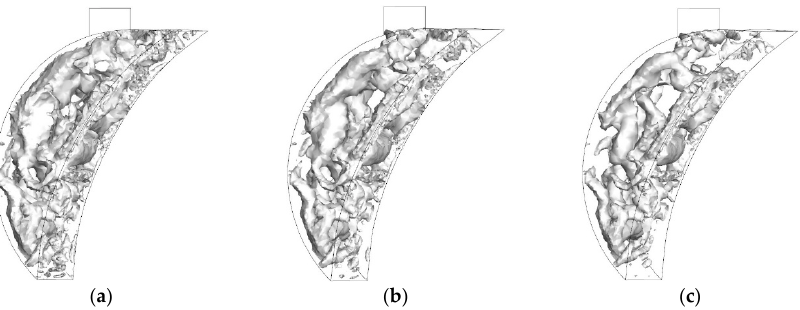
Figure 7. Vortex fields at 360° BTDC under different Q values. ( a ) Q = 10 6 s − 1 ; ( b ) Q = 10 7 s − 1 ; ( c ) Q = 10 8 s − 1 .